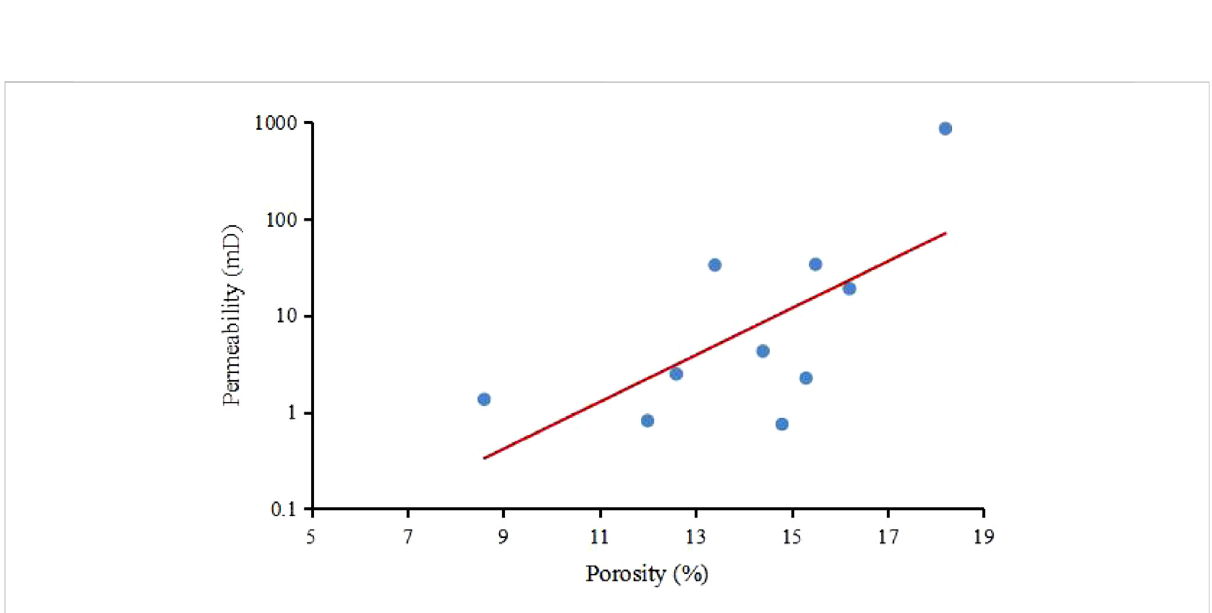
FIGURE 5 Relationship between porosity and permeability of the target